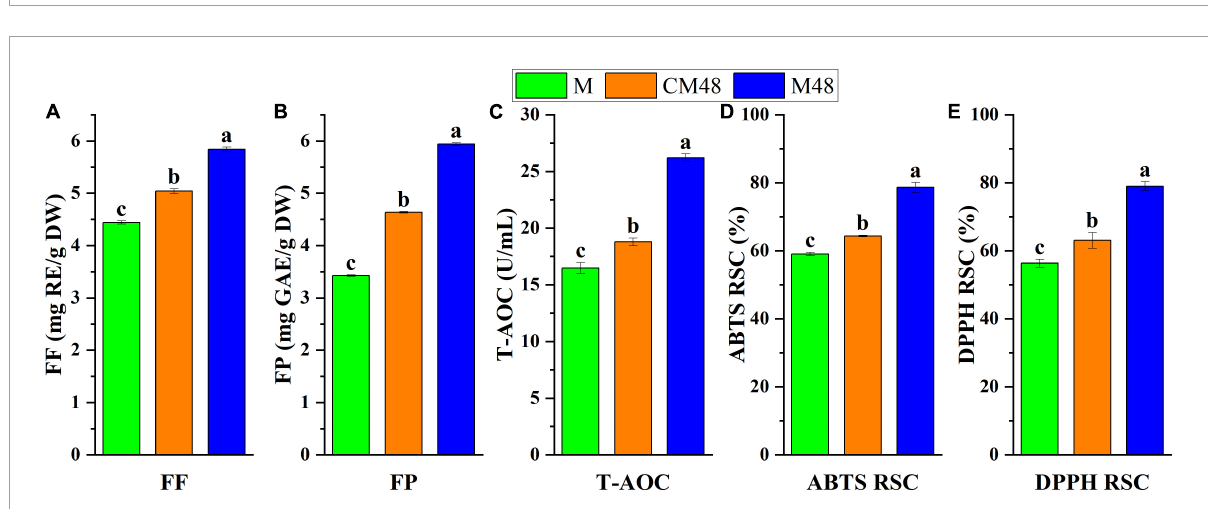
FIGURE4 The free flavonoids content (A) , free polyphenols content (B) , and total antioxidant capacity (C) , ABTS radical scavenging activity (D) , and DPPH radical scavenging activity (E) of sprouted mung bean. M, mung bean; CM48, mung bean germinated for 48 h; M48, mung bean pretreated with a combination of ultrasonic and γ -aminobutyric acid (GABA) germinated for 48 h; FF, free flavonoids; FP, free polyphenols; T-AOC, total antioxidant capacity; ABTS, 2,2-Azino-bis-3-etilbenzotiazolin-6-sulfonic acid; DPPH, 2,2-diphenyl-1-picrylhydrazyl; RSC, radical scavenging capacity.